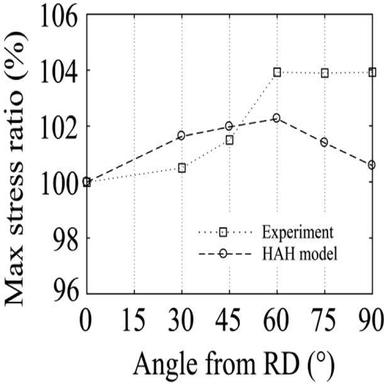
Experimental and simulated (with the HAH model) maximum stress ratio for tension-tension tests at various angles from the RD.